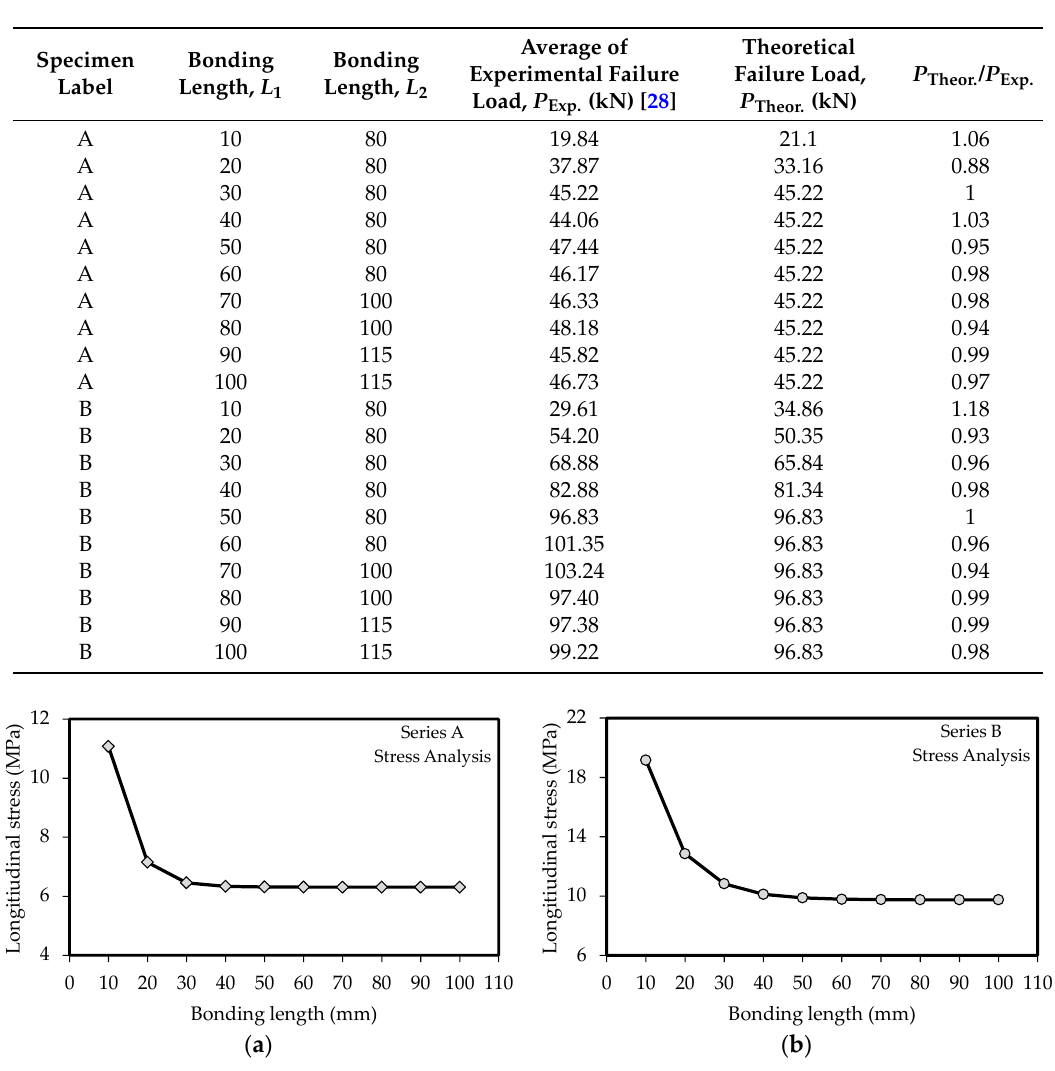
Table 6. Details of experimental results with theoretical failure load predictions for the joints series A and B.